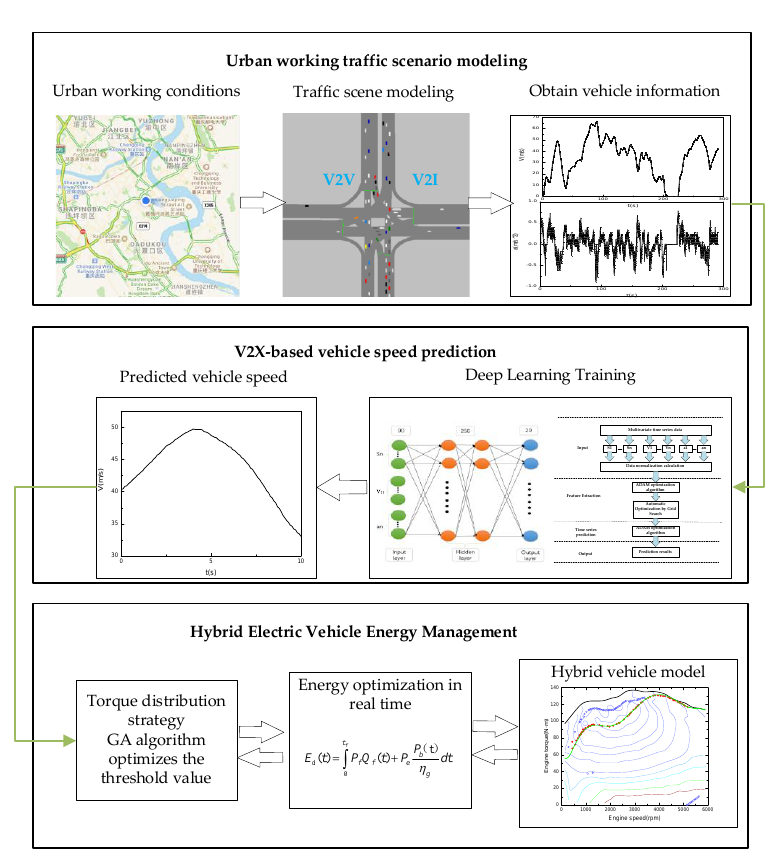
Figure 14. Overall structure of the proposed energy management.